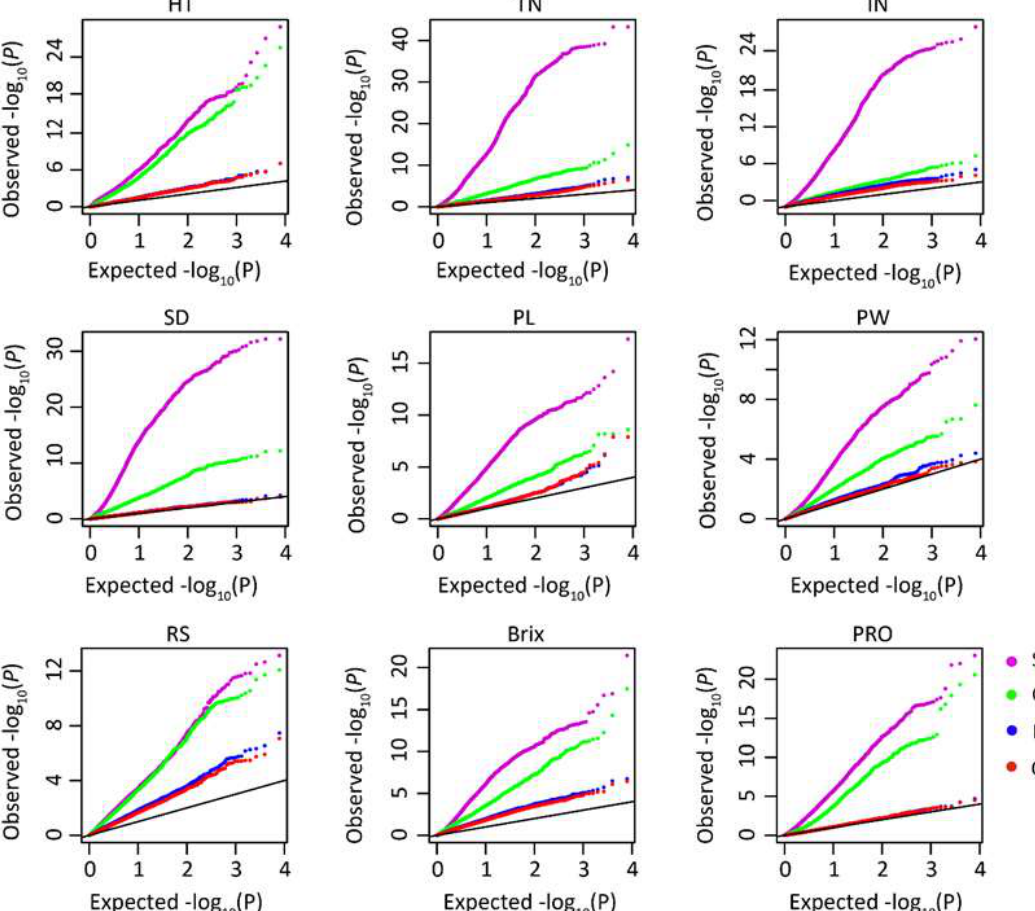
Figure 3. Quantile-quantile (QQ) plots for model comparisons with plant height (HT), tiller number (TN), internode number (IN), stem diameter (SD), panicle length (PL), panicle weight (PW), reducing sugar (RS), Brix, and protein concentration (PRO). The solid diagonal lines represent agreement between the observed and expected − log 10 ( p ) for marker-trait associations. Colored lines represent agreement between the observed and expected − log 10 ( p ) value for gene-trait associations analyzed with simple (S), population structure (Q), relative kinship (K), and Q + K implemented models, respectively.